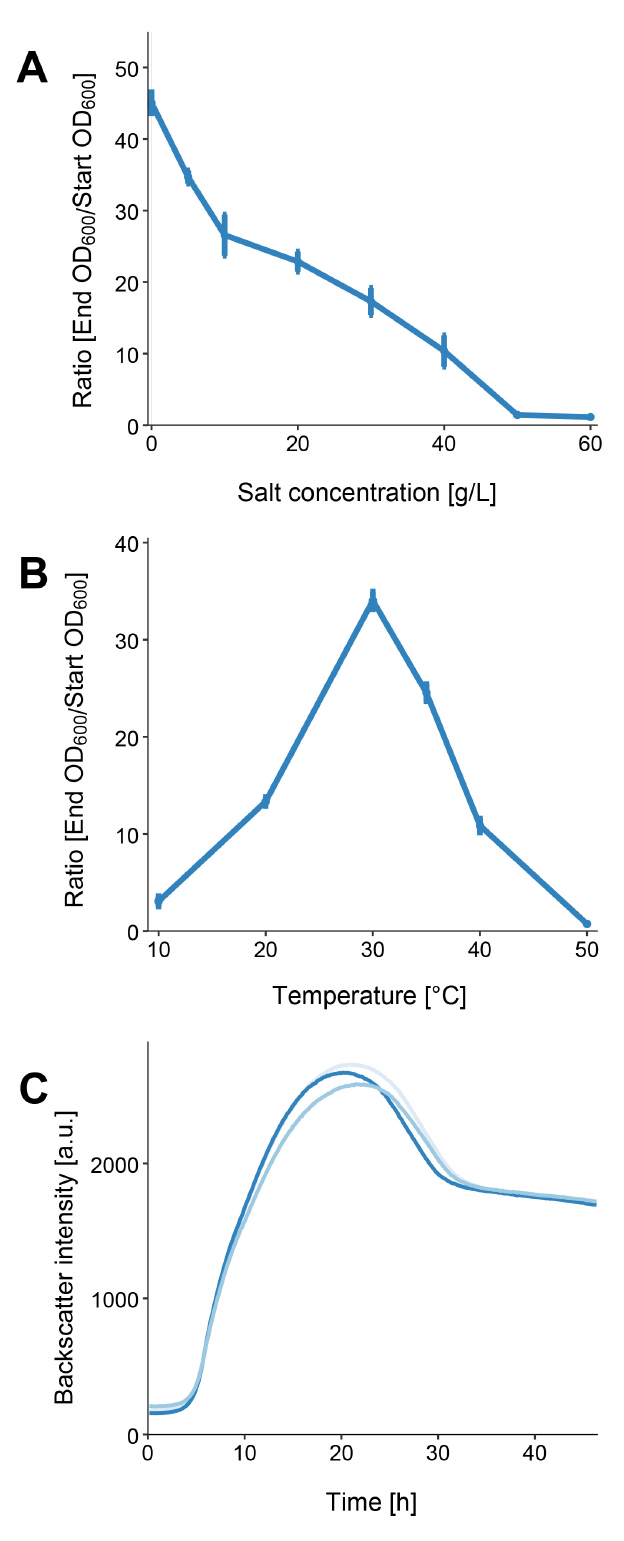
Figure 2. L. flocculans sp. nov. growth characteristics. ( A ) Growth of EIF3 T in 4 mL LB medium after 12 h of incubation at 180 rpm and 30 ◦ C with different salt concentrations. ( B ) EIF3 T growth at various temperatures in LB-0 medium after 12 h of incubation at 180 rpm. ( C ) Growth characterization of EIF3 T in 25 mL LB-0 medium at the optimal temperature (30 ◦ C). Triplicate measurements were conducted. Standard deviations in ( A , B ) are indicated by the error bars. In ( C ) various shades of blue represent each biological